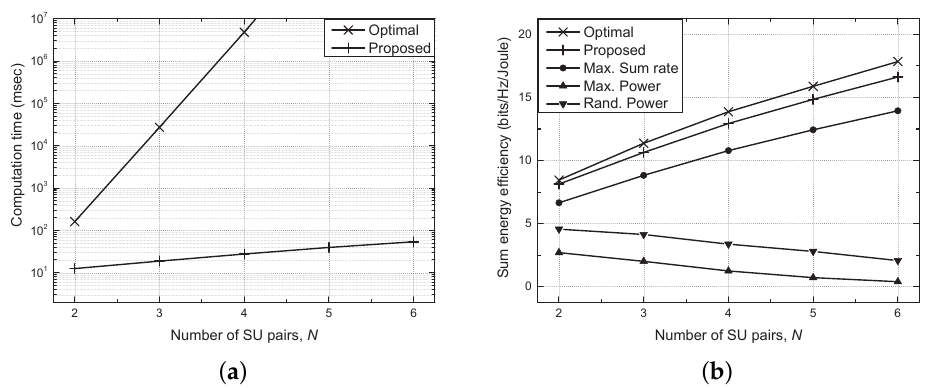
Figure 6. Performance comparison versus the number of SU pairs ( N ). ( a ) Computation time vs. N . ( b ) Sum energy efficiency vs. N